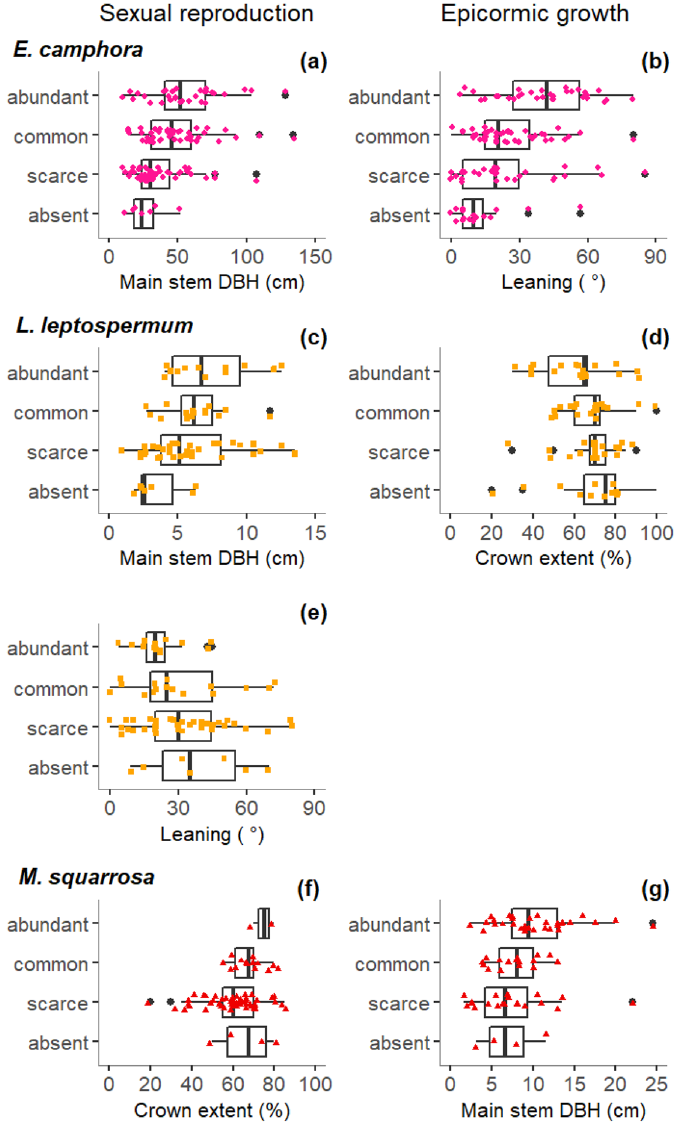
Figure 5. Relationships between morphology variables and sexual reproduction and epicormic growth for E. camphora , L. leptospermum and M. squarrosa . Only relationships for predictor variables with a significant independent contribution > 0.30 to the explained variance are shown. Points indicate raw data (n = 111 for E. camphora , n = 76 for L. lanigerum , n = 77 for M. squarrosa ). DBH = Diameter at breast height. The figure was generated in R version 3.5.0 (https:// www.r- proje ct.